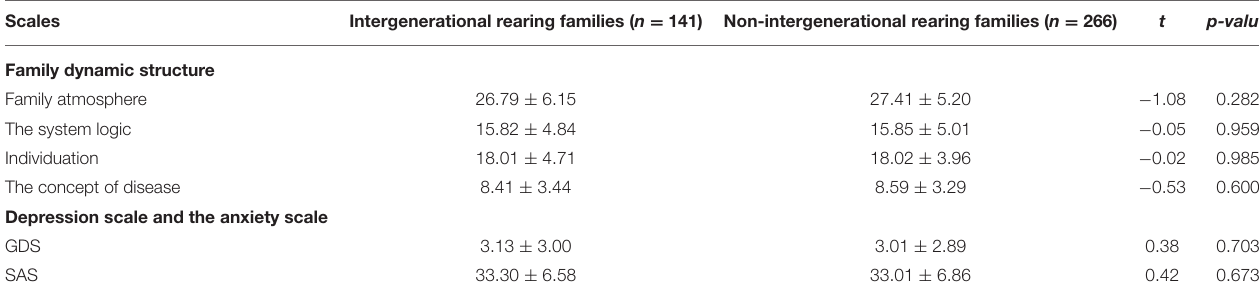
TABLE 2 | The comparison of dimensions scores of family dynamics, total scores of grandparents’ anxiety-depression in such two kinds of families. (¯x ± s).